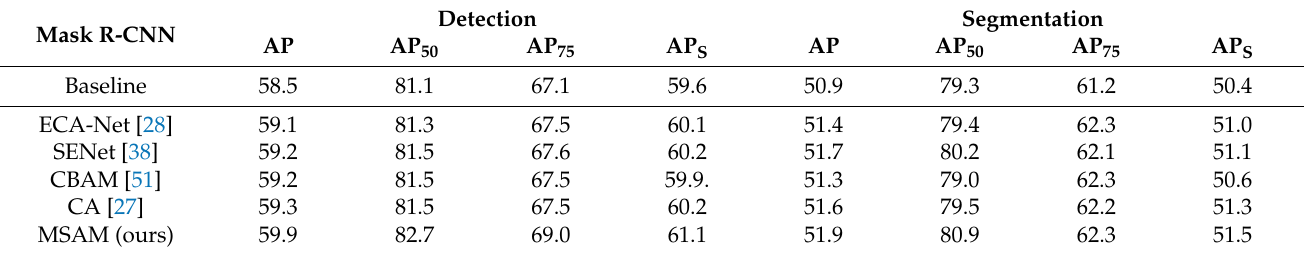
Table 4. Comparison of MSAM to classic attention mechanisms.